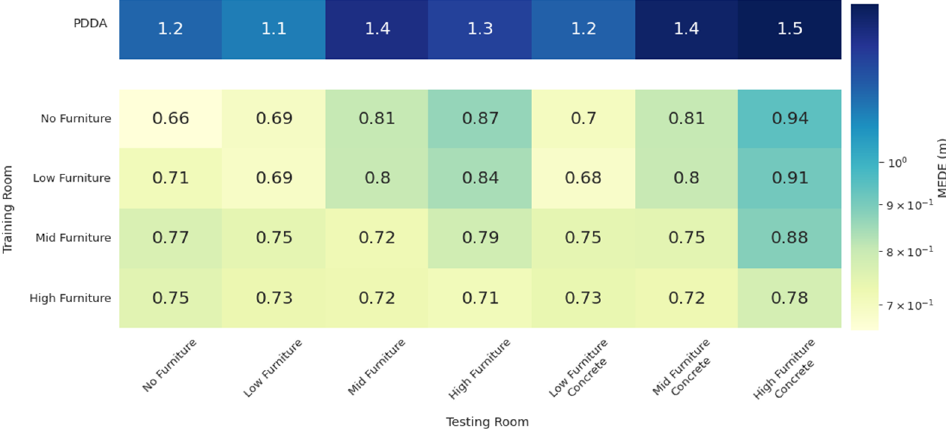
room is included for reference.